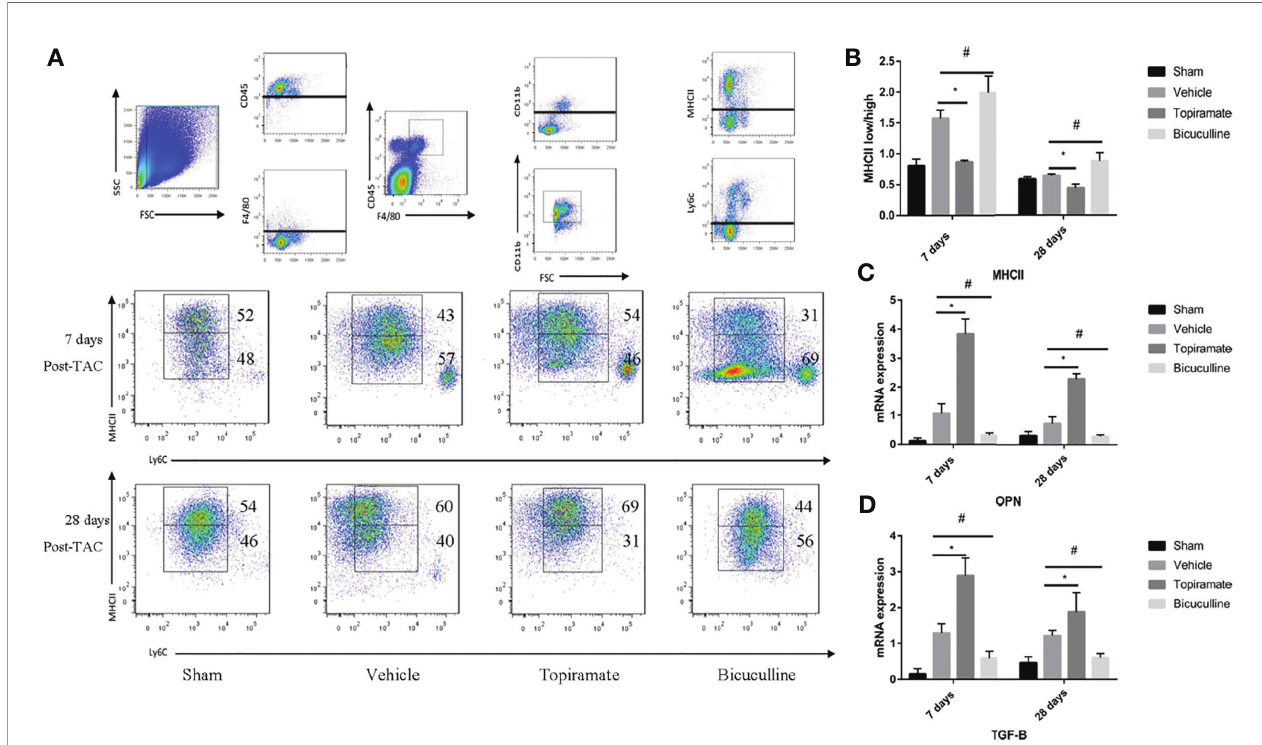
FIGURE 7 | The GABA A receptor affects fi brosis by regulating MHCII low /MHCII high ratios in subpopulations of Ly6C low macrophages. Ly6C low macrophages could be further classi fi ed into two subpopulations based on MHC II proteins. (A) Representative images of MHC II high and MHC II low macrophages at days 7 and 28 post-TAC in heart. (B) Quanti fi ed analysis of the percentage of MHC II low and MHC II high macrophages at days 7 and 28 post-TAC. (C, D) Relative mRNA expression of OPN (C) , and TGF-B marker genes (D) at days 7 and 28 post-TAC in the heart. Data show the mean ± SEM, by one-way ANOVA with Bonferroni ’ s multiple comparison test. For topiramate treatment, *P < 0.05 vs. vehicle. For bicuculline treatment, # P < 0.05 vs. vehicle. (each group, n =